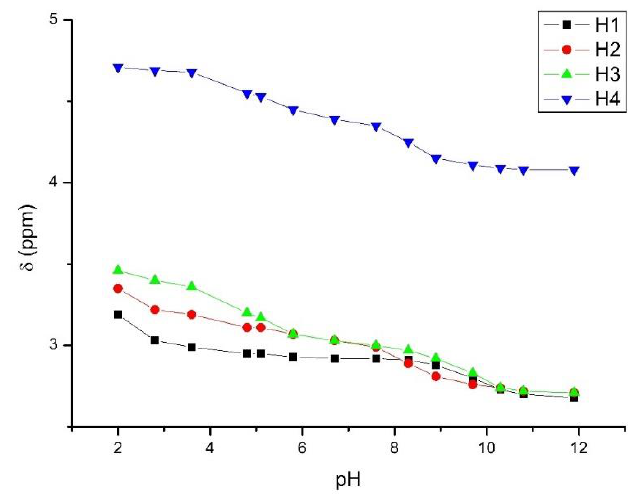
Figure 5. Trend of selected 1 H NMR signals of aliphatic L protons in an acetonitrile – d 3 /D 2 O 60:40 solution as a function of the pH. [ L ] = 5 × 10 – 3 mol dm −3 . See Figure 1 for the assignments.